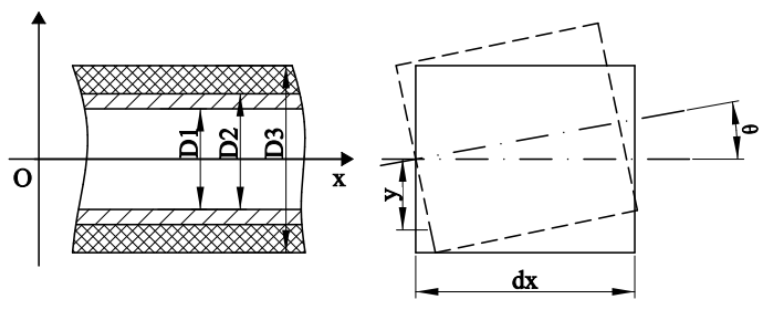
Figure 3. Mechanical model of the long coated damping structure.